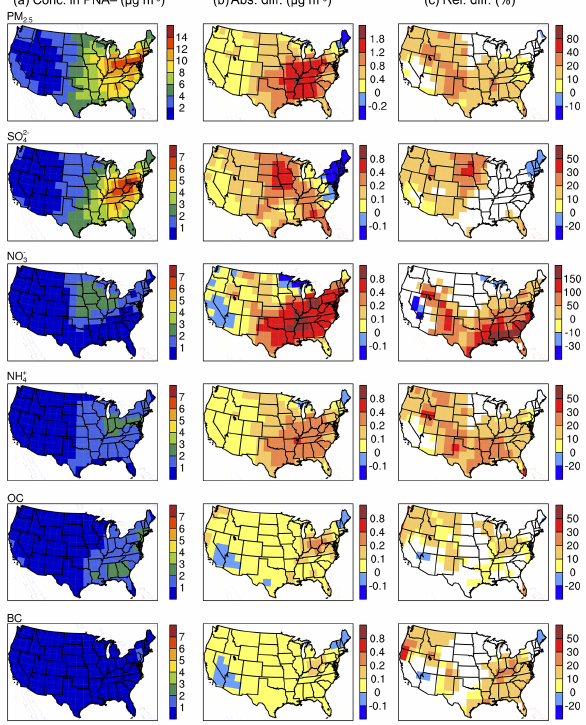
Figure 5. (a) Simulated concentrations (µgm − 3 ) of PM 2 . 5 and each aerosols species averaged over the PNA − months of 1986–2006. (b) The absolute differences (µgm − 3 ) in simulated aerosol concen- trations between PNA + and PNA − months (PNA + minus PNA − ). (c) The relative differences (%) in simulated aerosol concentrations between PNA + and PNA − months. The white spaces in (c) indi- cate the areas that did not pass the two-tail student t test with 90% significance level. The seasonal cycles of simulated aerosol concen- trations were removed. See Fig. 2c for the definitions of PNA + and PNA −